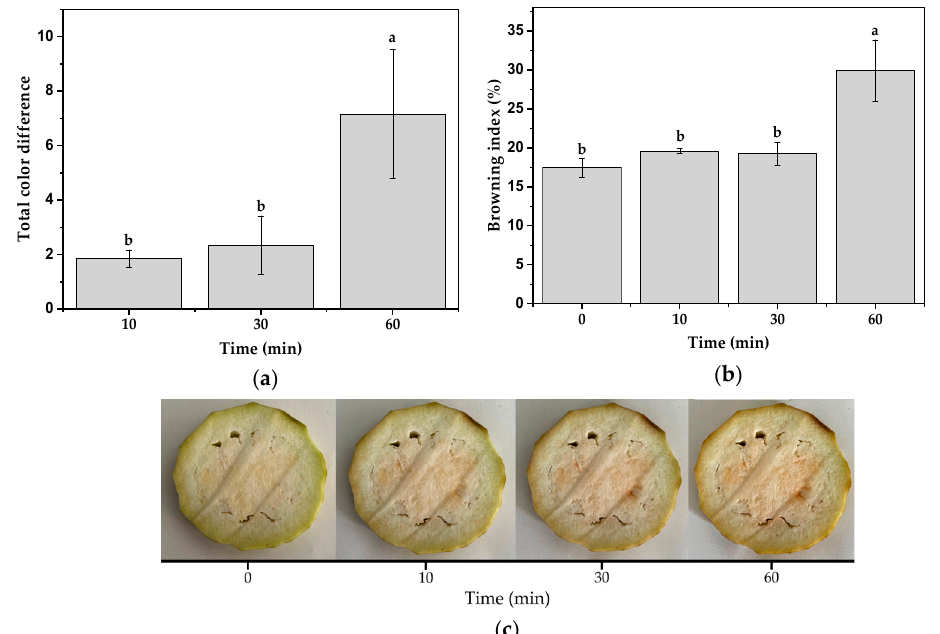
Figure 4. ( a ) The total color difference ( ∆ E) of samples comparing to time 0 min; ( b ) the browning index (BI) of samples; ( c ) the pictures of the samples in different times. Results are indicated as mean ± SD ( n = 3). Different small letters indicate a significant difference ( p ≤ 0.05, one-way ANOVA, Tukey’s HSD test).